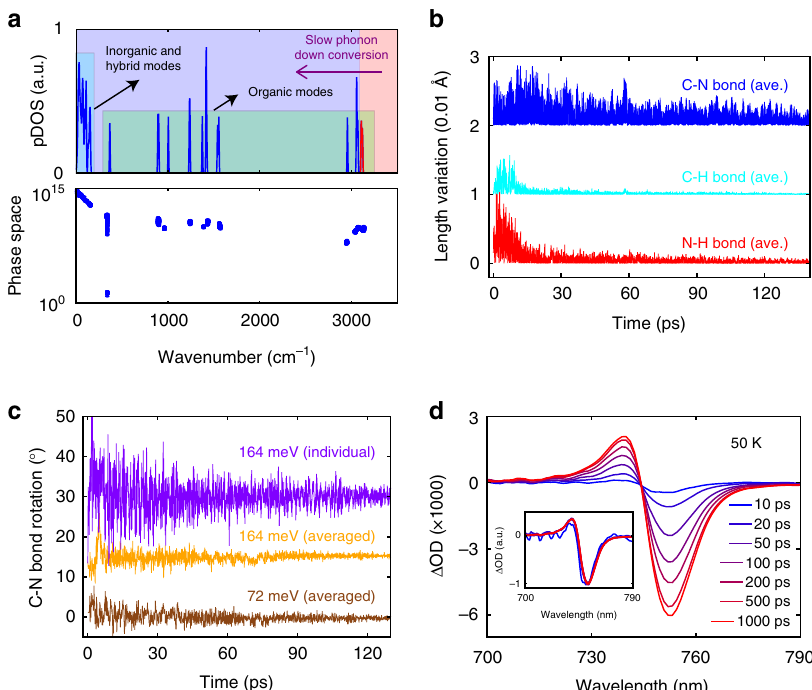
Fig. 3 First-principles calculation of the phonon dynamics for orthorhombic CH 3 NH 3 PbI 3 . a Calculated zero-Kelvin phonon density of states (pDOS) and phonon scattering phase space. b Absolute variation in the N-H (red), C-H (cyan), and C-N (blue) bond lengths from ab initio molecular dynamics (AIMD) simulations. Data are averaged over the four CH 3 NH 3 + cations in the orthorhombic unit cell. Initial imparted energy is 164 meV (per unit cell). c Variation in the C-N bond angle for different, indicated amounts of energy imparted into the unit cell. The purple curve is for a representative C-N bond; orange and brown curves are data averaged over all of the four CH 3 NH 3 + cations in the orthorhombic unit cell. Data in ( b , c ) are offset for clarity. d Transient Δ OD spectra acquired at several different delay times; inset shows the overlapped transient spectra in arbitrary units by simple scaling. Fluence used was 0.45 mJ cm −